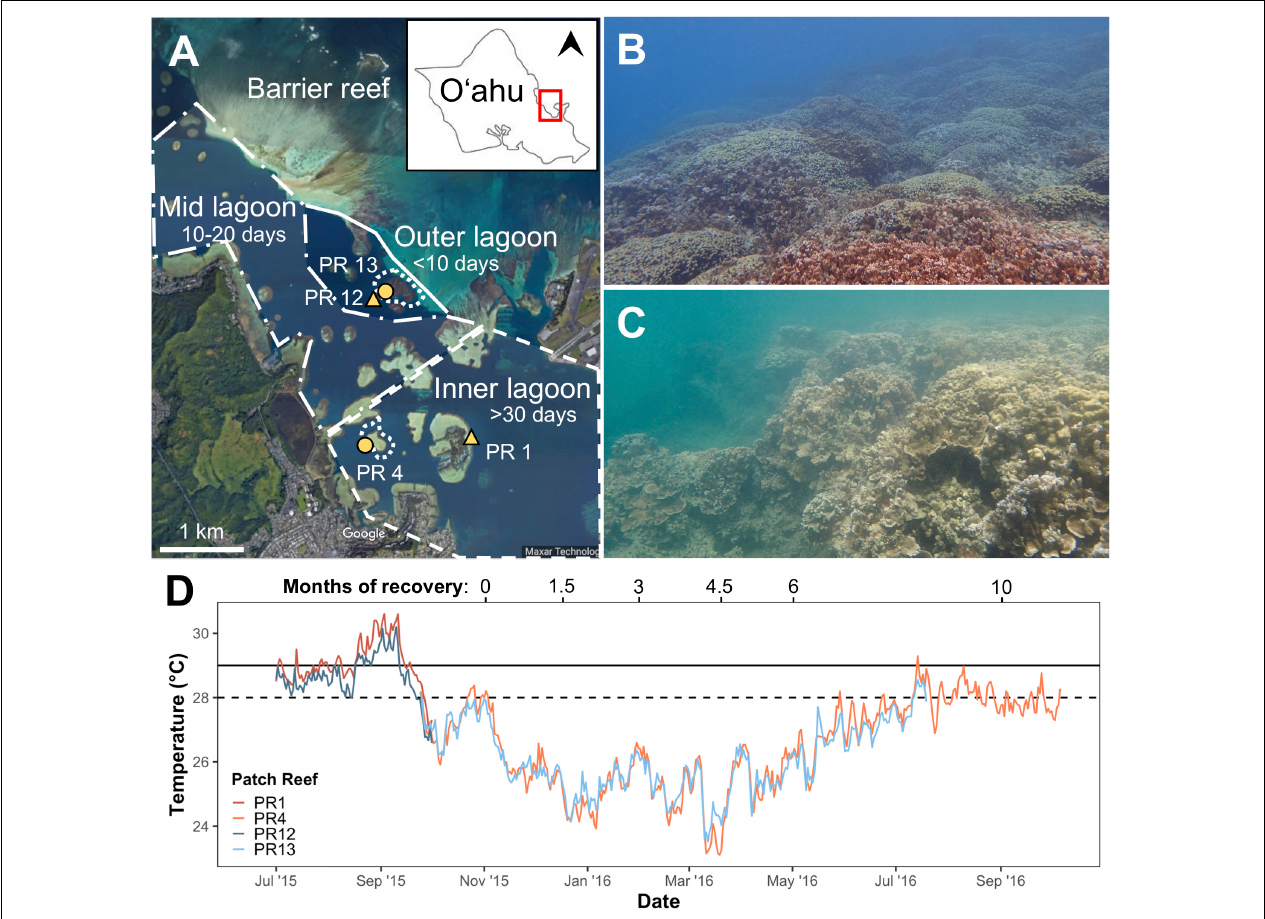
FIGURE 1 | (A) Map of the southern region of K¯ane‘ohe Bay, O‘ahu. Inset shows the island of O‘ahu, with north indicated by the arrowhead and the red square indicating the southern region of K¯ane‘ohe Bay enlarged in detail. Distinct hydrodynamic regimes within the lagoon are indicated by the polygons: the dashed line surrounds the Inner Lagoon region where seawater residence times are > 30 days; the dash-dot line surrounds the Mid Lagoon region where seawater residence times are 10–20 days; the solid line surrounds the Outer Lagoon region where seawater residence times are < 10 days (from Lowe et al., 2009). Yellow symbols indicate locations of in situ temperature loggers. Representative images of each reef are shown for (B) Outer lagoon (PR13) and (C) Inner lagoon (PR4). (D) Maximum daily temperatures at each reef. Dashed horizontal line indicates local MMM; solid horizontal line indicates coral bleaching threshold (MMM+1).